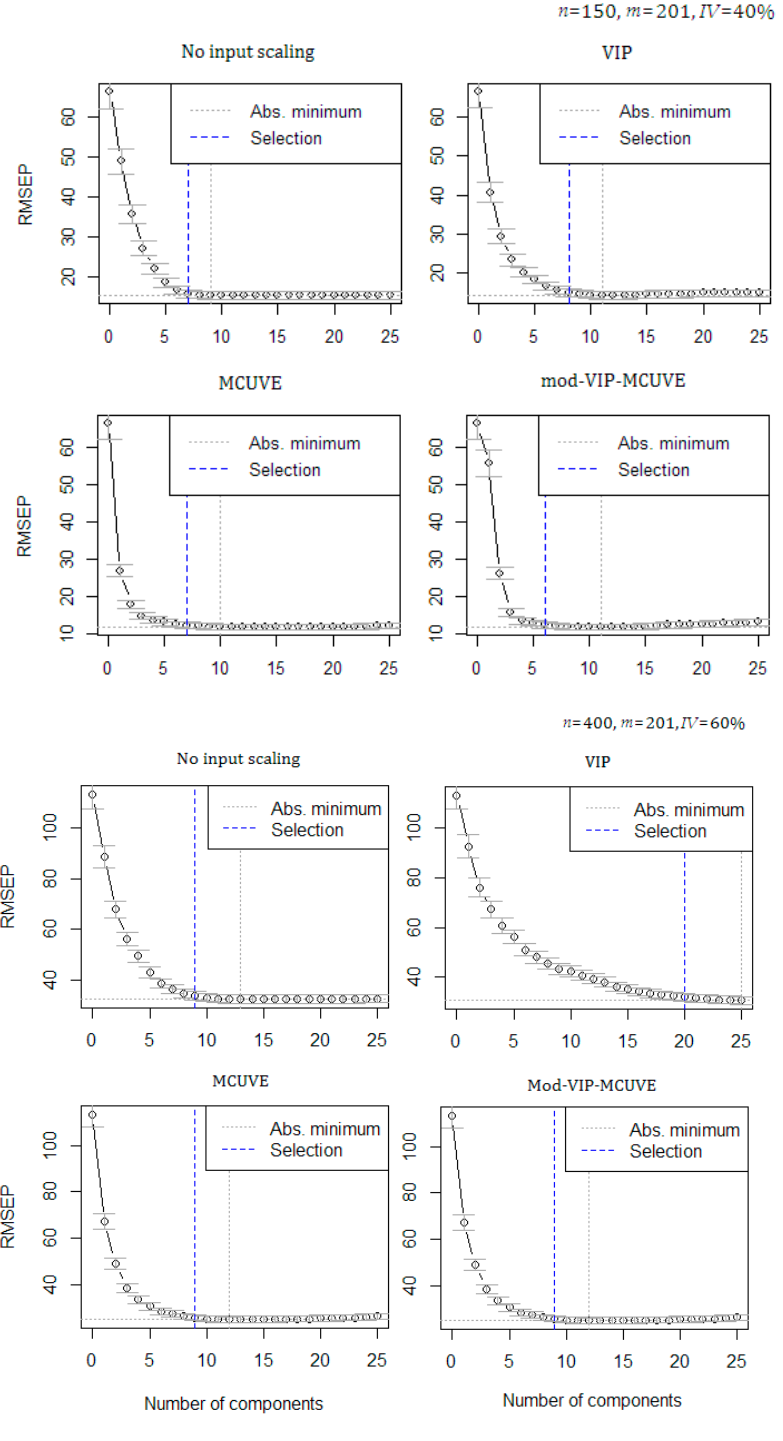
Figure 1. Global minimum cross-validation for the optimum number of PLS components on different dataset scenarios.